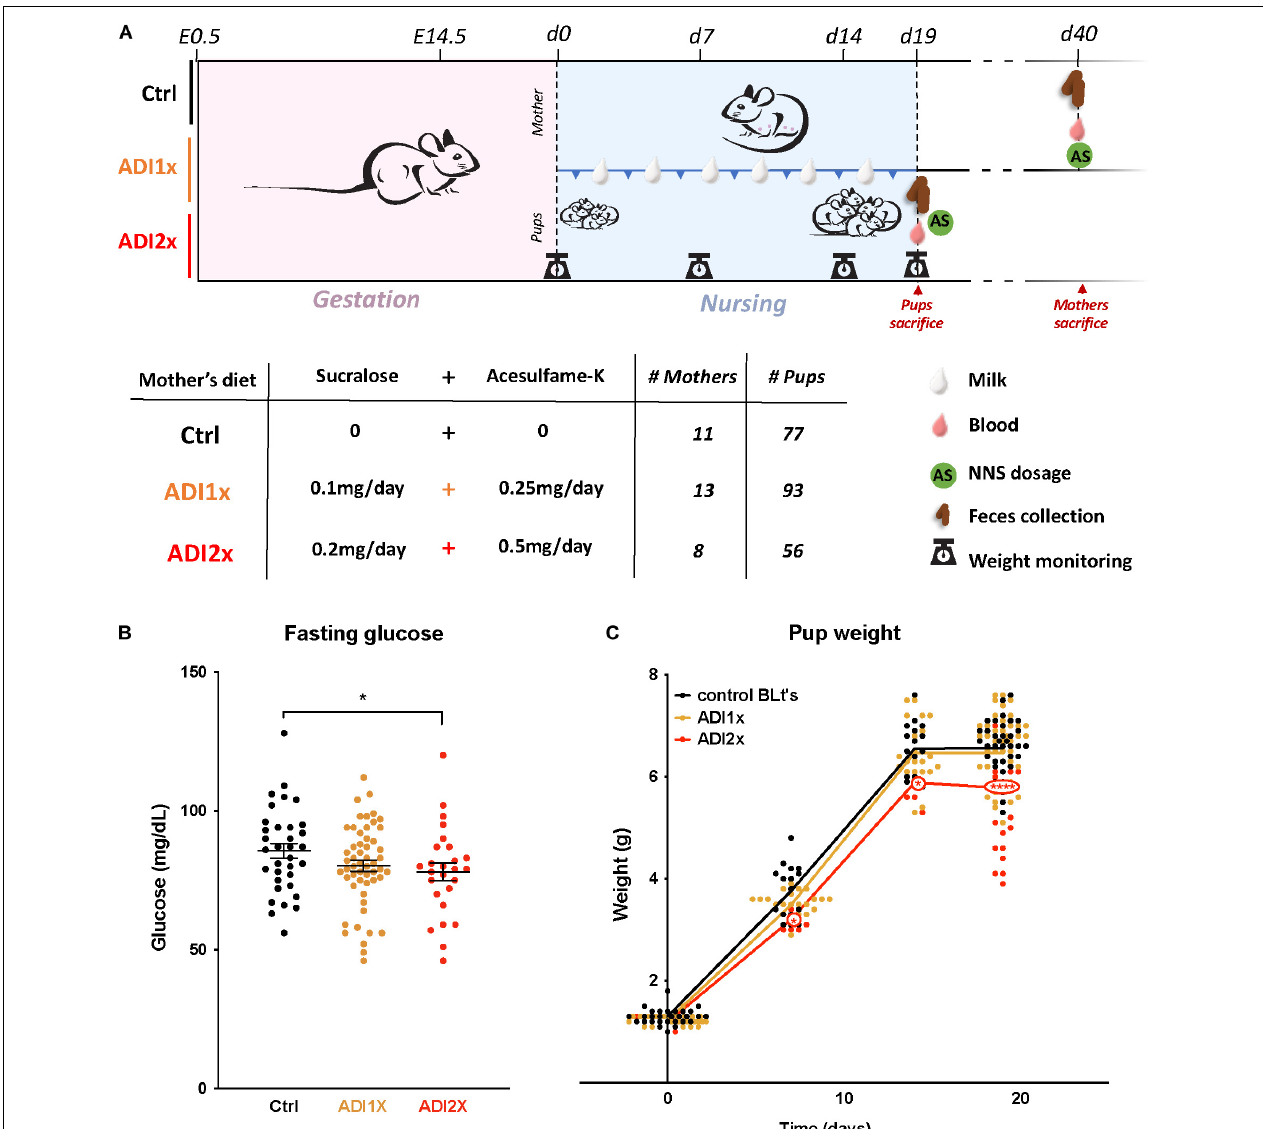
FIGURE 1 | Pups born to NNS-exposed mothers have observable metabolic phenotypes. (A) Experimental design: Mothers were fed starting on day 0.5 post-coitus (E0.5) until sacrifice. Two different concentrations of sucralose and acesulfame-K (ADI1x and ADI2x) were used for the experiments. Pups were sacrificed on postnatal day 20 (d20), and mothers were sacrificed after. All mice were fasted, weighed and blood was drawn before sacrifice. (B) Fasting glucose of 20-day old pups was measured before sacrifice ( n = 30) (ANOVA). (C) Pups’ weights were monitored from d1 to d20 and significance was analyzed using ANOVA ( n = 30). Significance values: ∗∗∗∗ p < 0.001, ∗ p <